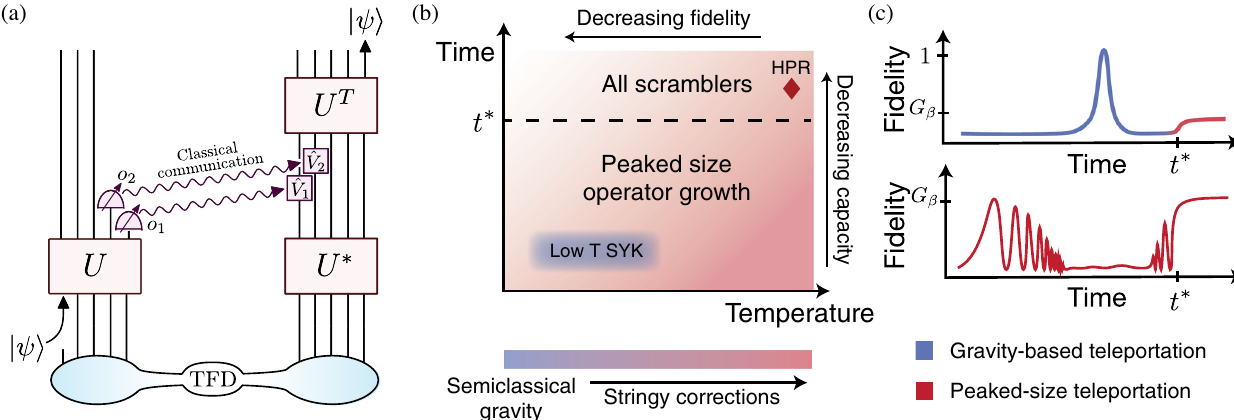
ˆ O FIG. 1. (a) Teleportation protocol, proceeding from bottom to top. To teleport, a subset of the left qubits are measured in the basis, i ˆ V e igo i ˆ O i =K conditioned on the measurement results o and operations are performed on the right (purple). (b) The protocol hosts two i ¼ i mechanisms of teleportation: peaked-size (red) and gravitational (blue). The channel capacity of peaked-size teleportation decreases with increasing time (dark to light red), while its fidelity decreases with decreasing temperature (dark to light red, again). At high temperature and late times, it is equivalent to teleportation in the HPR protocol (red diamond). Gravitational teleportation occurs at low temperatures in systems dual to semiclassical gravity (e.g., the SYK model) and exhibits the same channel capacity but higher fidelity compared to peaked-size teleportation. Increasing the strength of stringy corrections to the gravity theory interpolates between gravitational and peaked-size teleportation. (c) The two mechanisms display distinct time profiles for the teleportation fidelity at fixed coupling strength g . In systems dual to gravity (top), the fidelity features a single O ð 1 Þ peak near the scrambling time (gravitational, blue) and a late-time revival (peaked-size, red) to a fidelity suppressed by the two-point function G β [7]. In generic thermalizing systems (bottom), the fidelity oscillates between 0 and G β with phase proportional to the operator size, may subsequently decay if sizes become not peaked, and revives at late